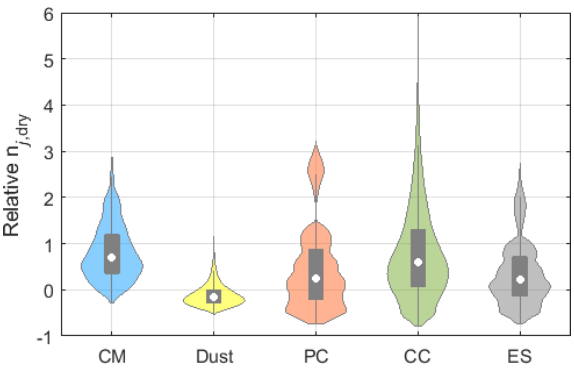
Figure 4. Violin plots for the output ensemble of n j, dry ( j = 100 for dust and 50 for other aerosol subtypes) relative to that of un- perturbed NVSD from the CALIPSO aerosol model. The filled shape shows the probability density of the data (smoothed by non- parametric kernel density estimator) along the y axis, symmetric on either side, representing a violin-like shape. The box limits repre- sent the first and third quartiles, the white circle inside the box is the median, and the ends of the grey line passing through the centre of the box represent the adjacent values (data excluding